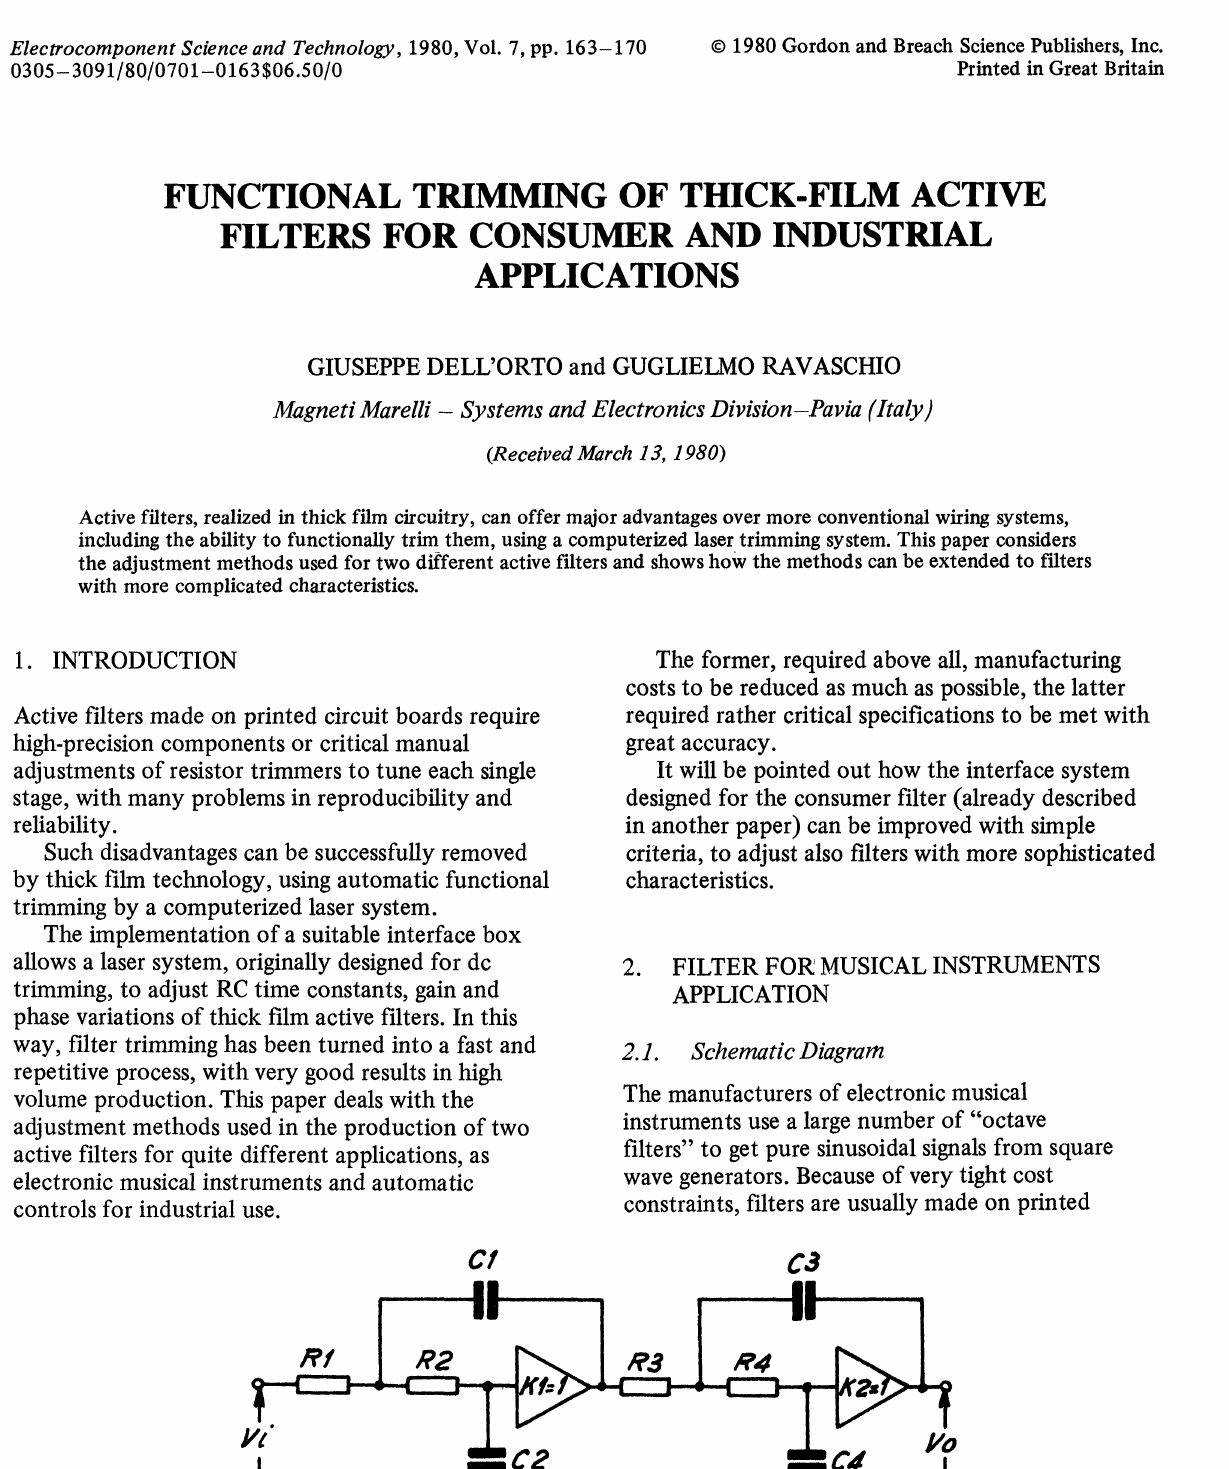
Sallen-Key filter